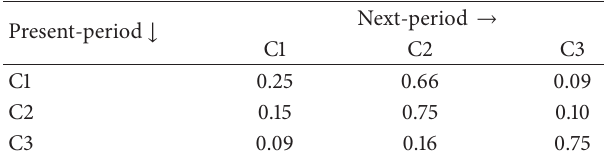
Table 1: Elderly individual’s interest transition probability based on statistical observation.